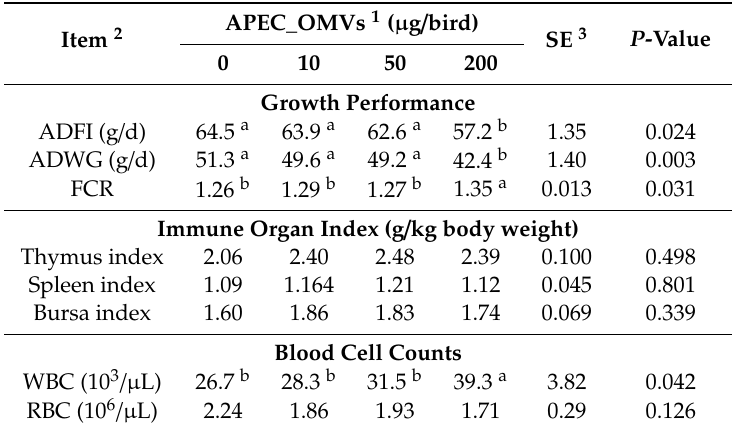
Table 1. E ff ects of various doses of APEC_OMV vaccination on the growth performance, immune organ index and blood cell